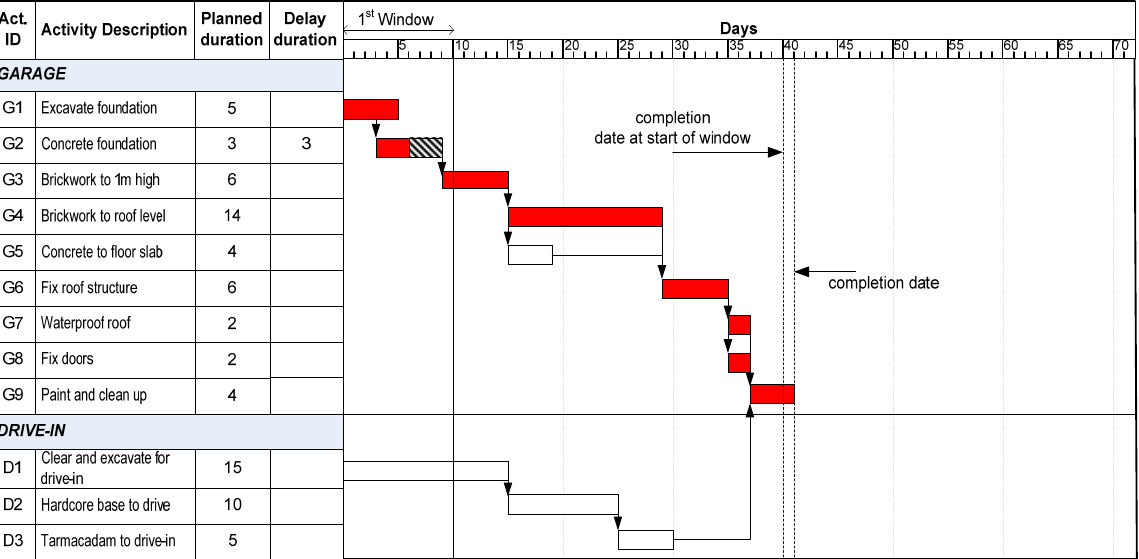
Figure 18. Updated schedule on day